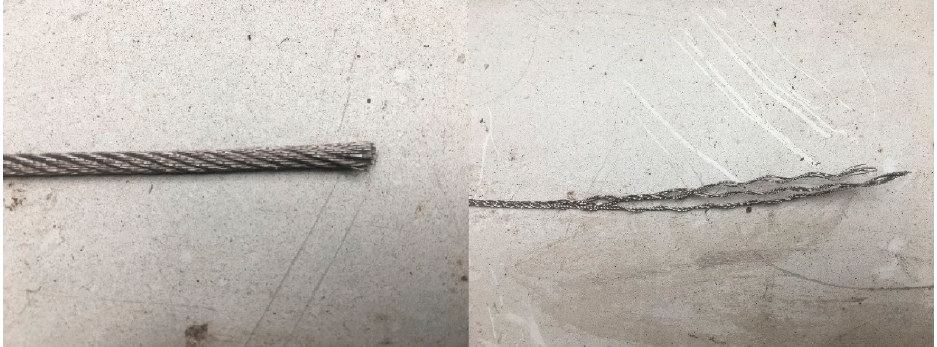
Figure 9. The twisted cable composed of 7 small sub-cables.